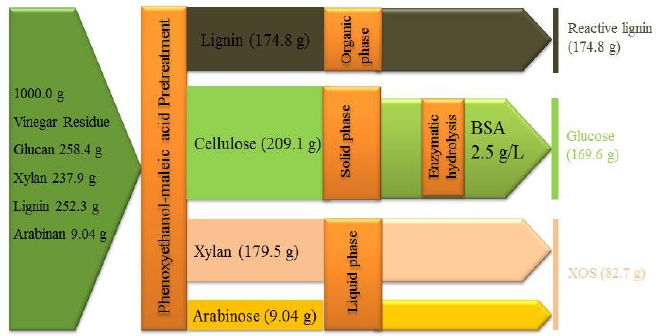
Figure 5. Mass balance for phenoxyethanol-MA pretreatment process.